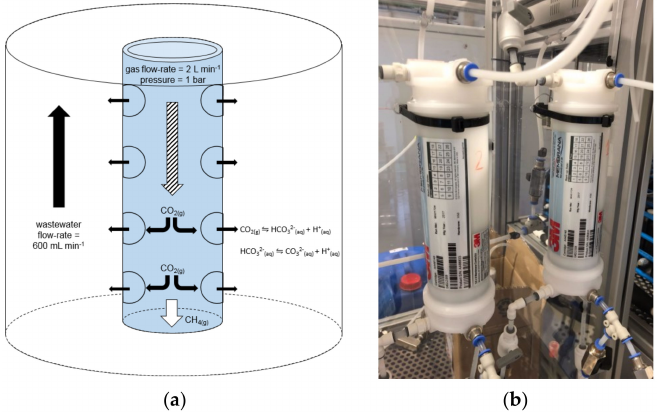
Figure 2. Membrane contactors for CO 2 capture: ( a ) operation parameters; ( b ) experimental